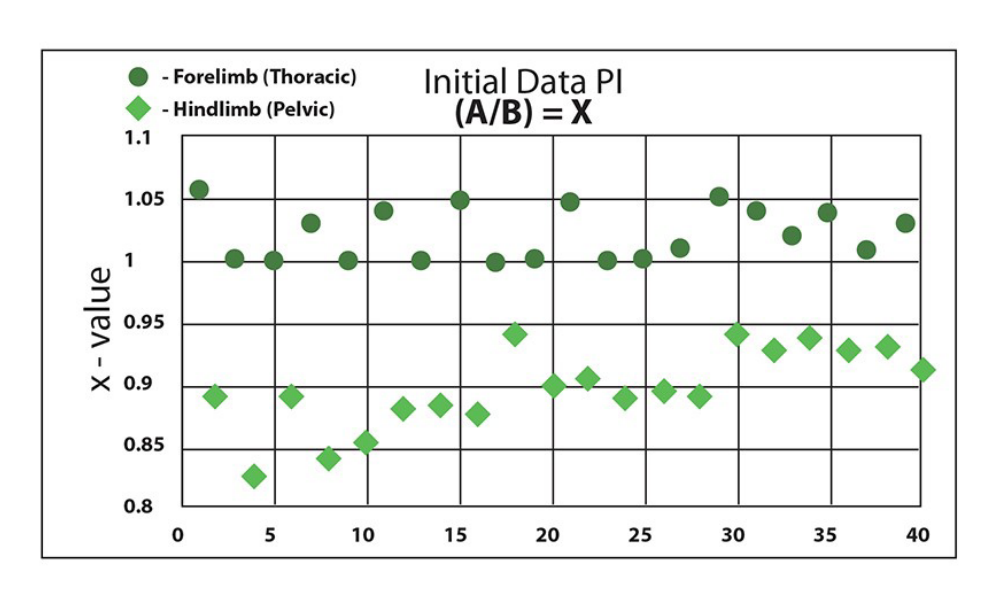
Figure 5. PI. Graph of values from the initial sample